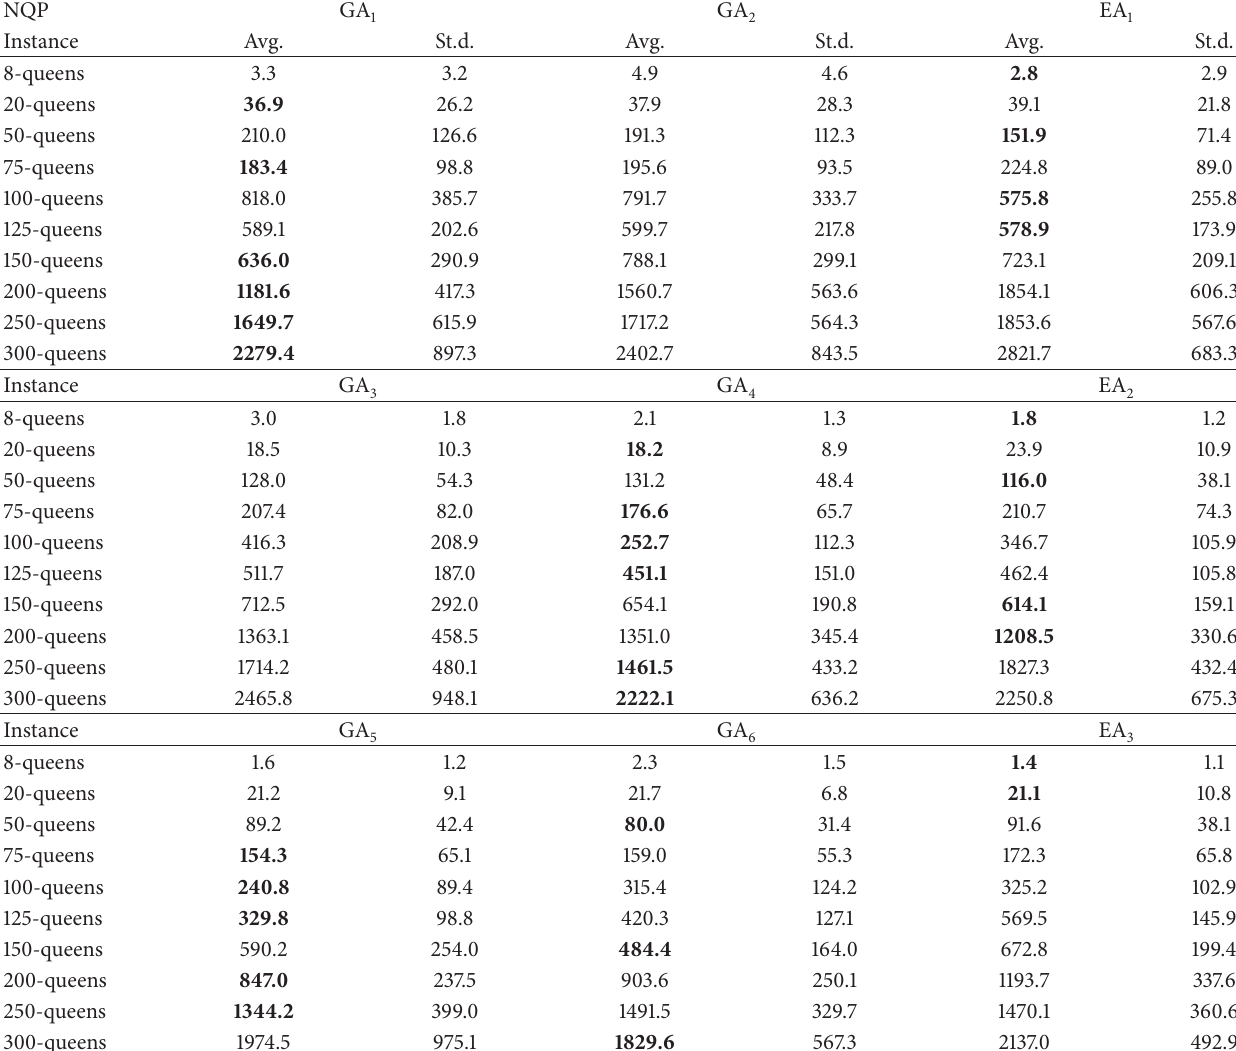
Table 9: Convergence behaviour of the nine techniques applied to the